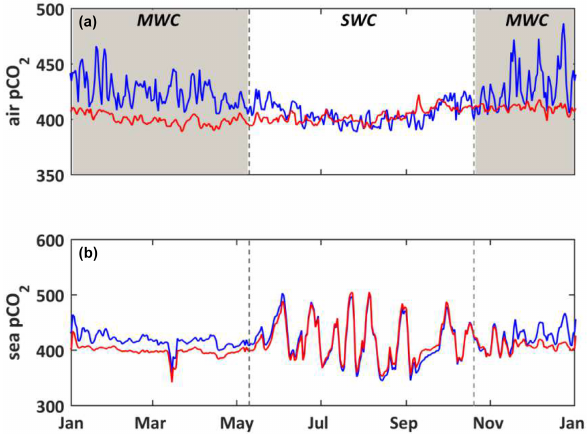
Figure 8. (a) Temporal evolution for the year 2017 of the observed p CO 2 (µatm) in the atmosphere at the CAV station, called the “ur- ban scenario” ( S 0, blue line), and at the OHP station, called the “non-urban scenario” ( S 6, red line). (b) Temporal evolution for the year 2017 of the modeled seawater p CO 2 (µatm) with forcings from the urban ( S 0, blue line) and non-urban (S6, red line) scenarios. The shaded area and dotted black lines delimit the SWC and MWC pe-